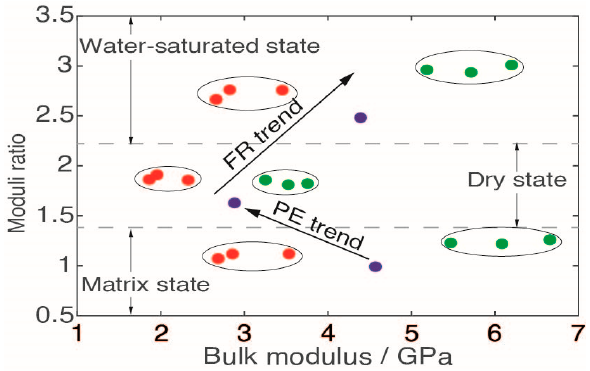
Figure 7. Cross-plots of bulk modulus vs. modulus ratio for core matrices, dry cores, and water-saturated cores. Blue dots are group one, indicating quartz-rich cores; green dots are group two, indicating boehmite-rich cores; and red dots are group three, indicating clay-rich cores. Transforming among states, the groups vary following pore embedding (PE) and fluid replacement (FR) trends.